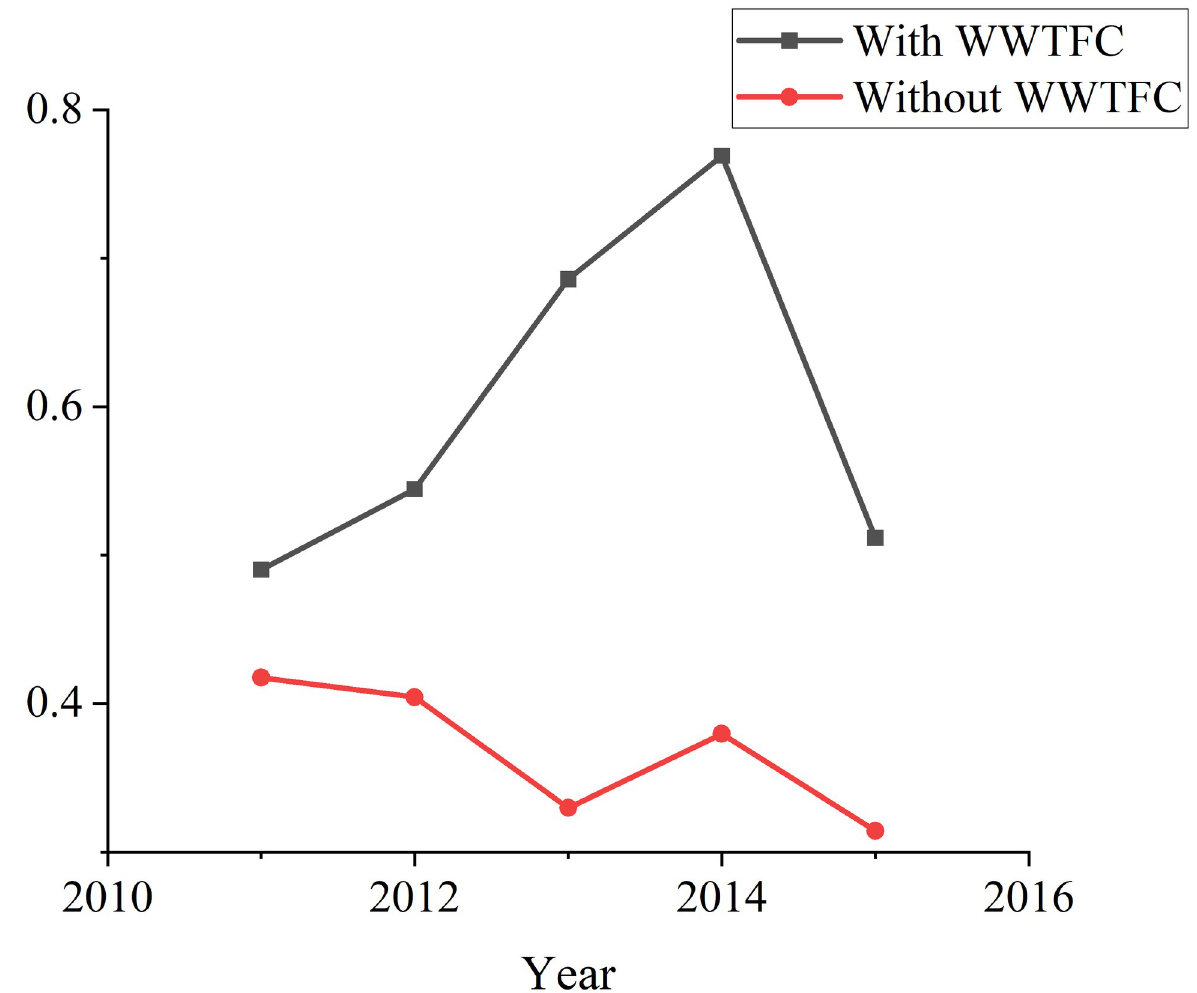
Fig 6. Average WWT efficiency during